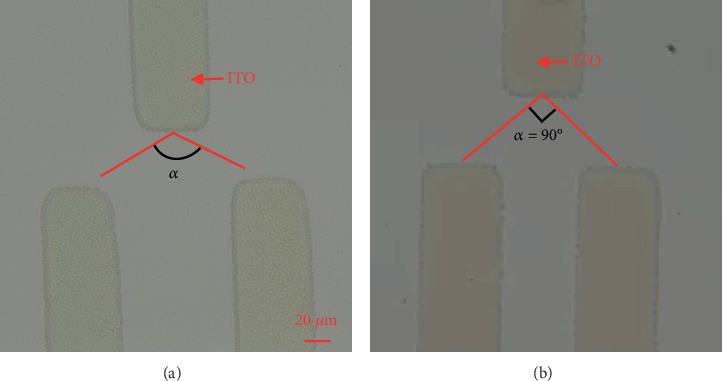
Schematic diagram of the distance between ITO electrodes (scale bar was 20 μm).